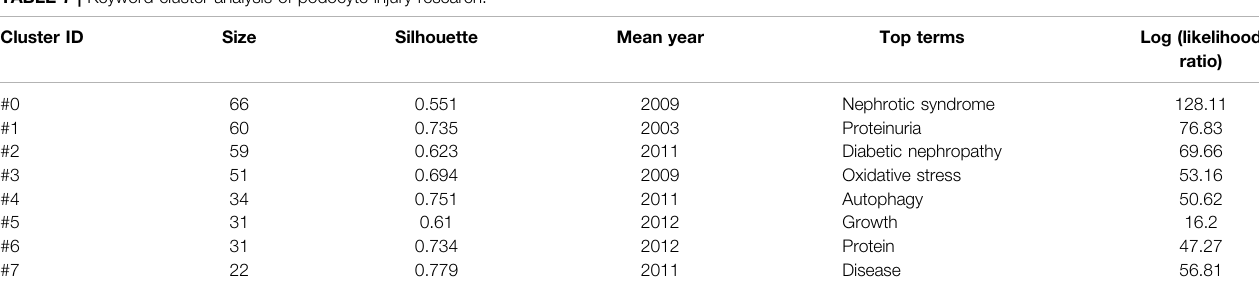
TABLE 7 | Keyword cluster analysis of podocyte injury